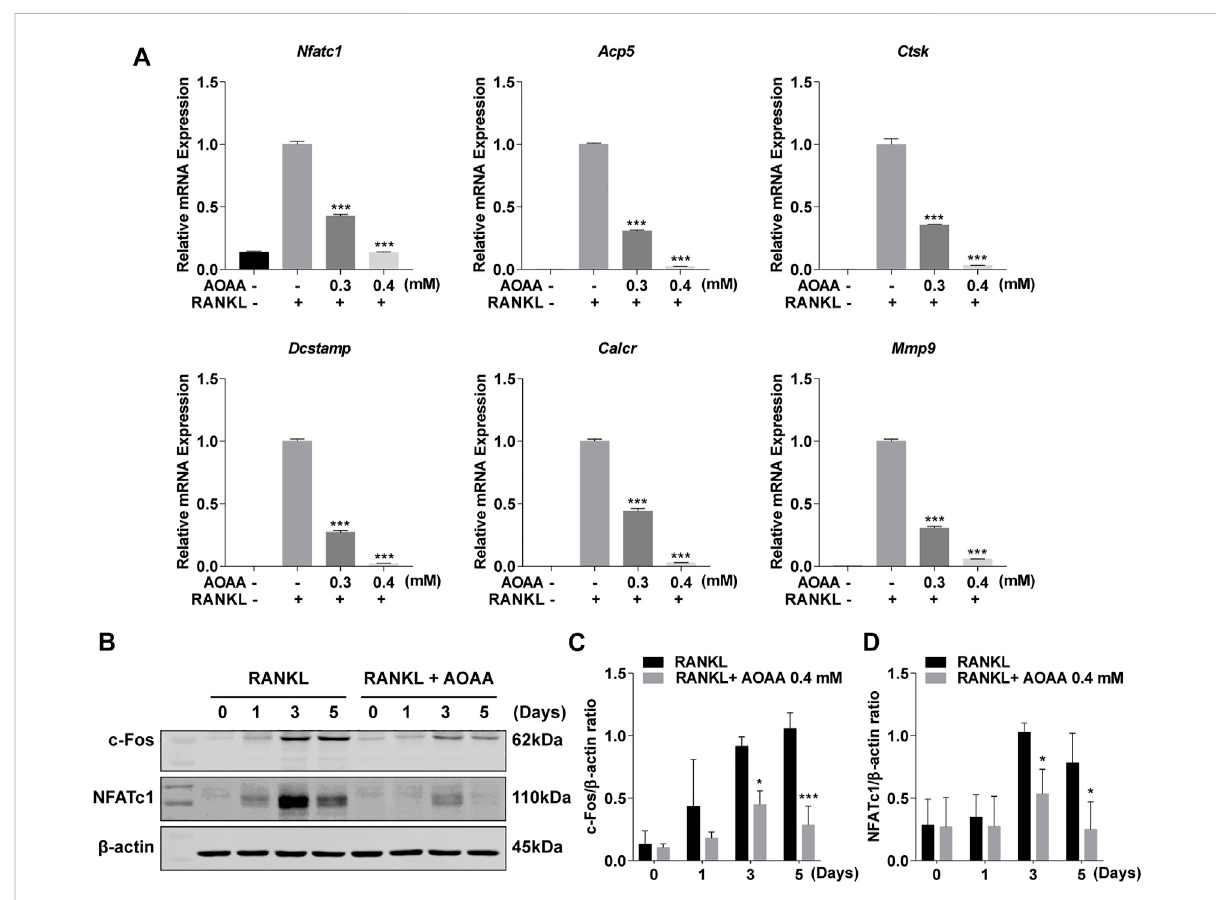
FIGURE 3 AOAA inhibits osteoclast-speci fi c gene expression. (A) The osteoclast-speci fi c gene expression of Nfatc1 , Acp5 , Ctsk , Dcstamp , Calcr , and Mmp9 werequantitativelydetectedbyqPCR(comparedwiththeAOAA − RANKL + group).One-wayANOVAwasused. (B) Representativewesternblot images of the effects of AOAA on NFATc1 and c-Fos expression. The leftmost bands of western blot represent the molecular weight marker. (C,D) Quanti fi cation of the ratios of band intensity of c-Fos and NFATc1 relative to β -actin (compared with RANKL-induced group at the same time point), two-way ANOVA was used. All experimental data are expressed as mean ± SD ( n = 3). *p < 0.05, ***p <